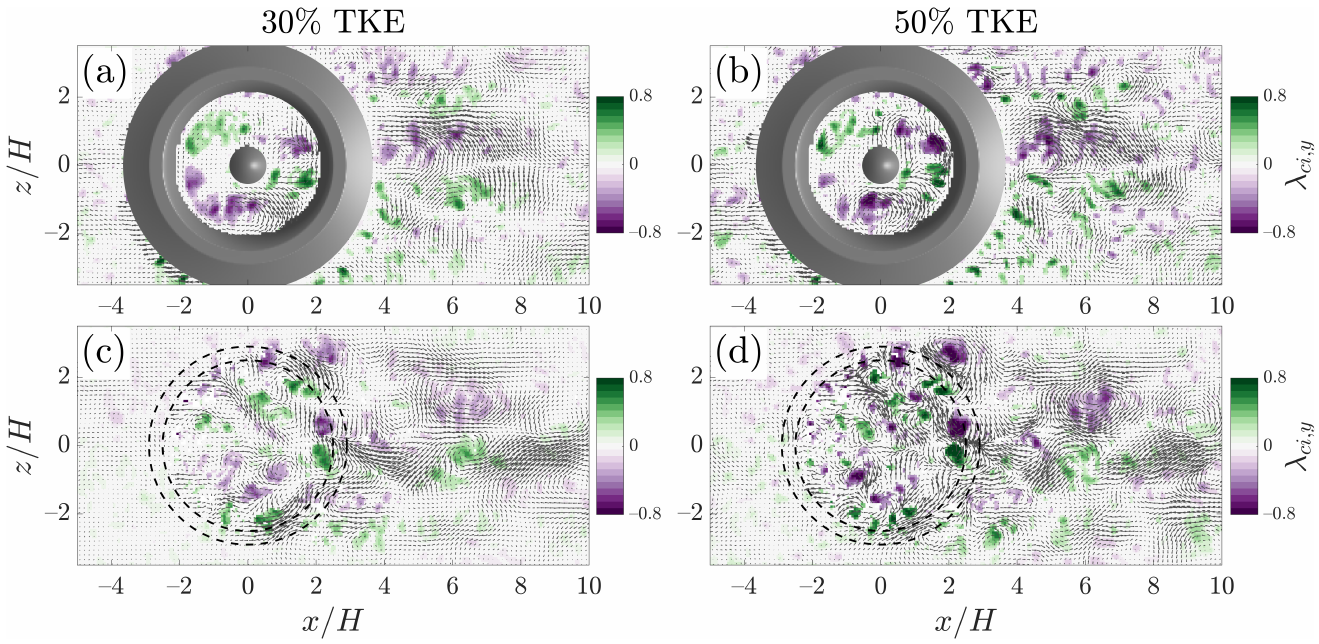
Figure 17. Contours of representative instantaneous wall-normal swirling strength, λ ci , y , in the wall-parallel measurement planes located at ( a , b ) y / H = 0.6 and ( c , d ) y / H = 1.1. The fields were reconstructed with numbers of modes corresponding to 30% ( left column ) and 50% ( right column ) of the TKE. Vectors show the corresponding fluctuating velocity components u (cid:48) and w (cid:48) at every other grid point. Re H = 8.9 × 10 3